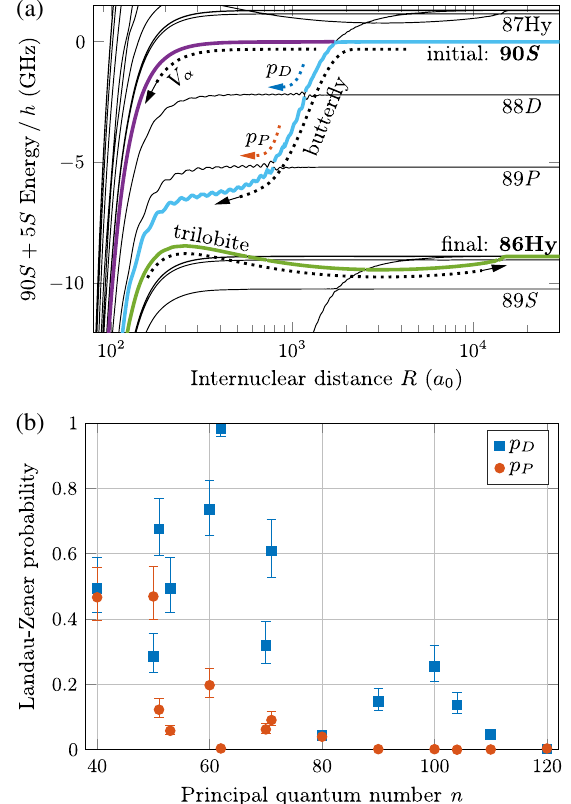
FIG. 4. (a) Potential energy landscape of the 90 S state, including the interaction between the Rydberg electron and a neutral atom and also the polarization potential V α of the Rydberg ionic core. At R ≈ 1700 a 0 , the 90 S and the neighboring butterfly state couples and causes an avoided crossing. From a classical viewpoint, neutral atoms initially at shorter distances than the crossing will follow the S potential until the ion neutral interaction takes over (violet). At larger distances, the probability to adiabatically follow the butterfly state at the crossing of the nS potential with the butterfly state is almost 1, as the neutral atom approaches the Rydberg ionic core. In both cases, a short-range coupling at R < 200 a 0 can lead to a state change to the trilobite state (green), which for large internuclear separations, turns into a high l state of the next-lower-lying hydrogen manifold (Hy). (b) Theoretical adiabatic Landau-Zener probabilities at the butterfly crossing with the D and P states as functions of the principal quantum number n . Appendix C explains how the error bars have been calculated.